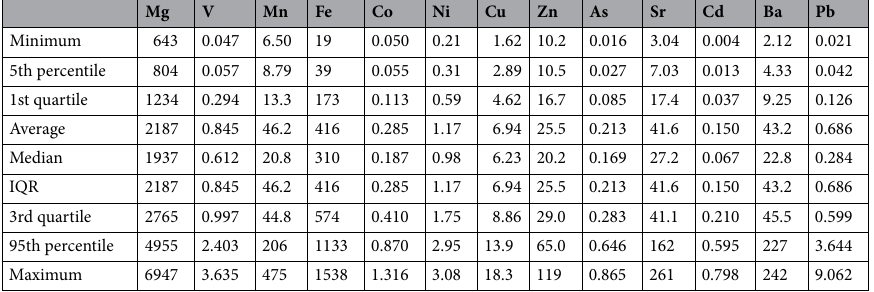
Table 5. Descriptive statistic of measurement results for 13 elements in 26 herbs each analyzed in two batches purchased 1 year apart ( n = 52 ). All values are in mg kg −1